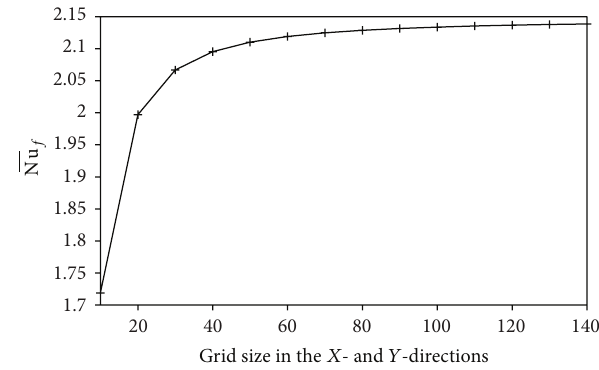
Figure 2: Grid independency study: Nu 𝑓 versus number of grid points at 𝐷 = 0.1 , Kr = 0.5 , and Ra = 10 5